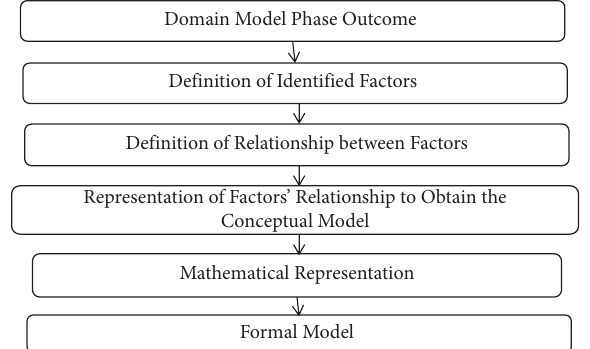
Figure 2: Factor organization activities